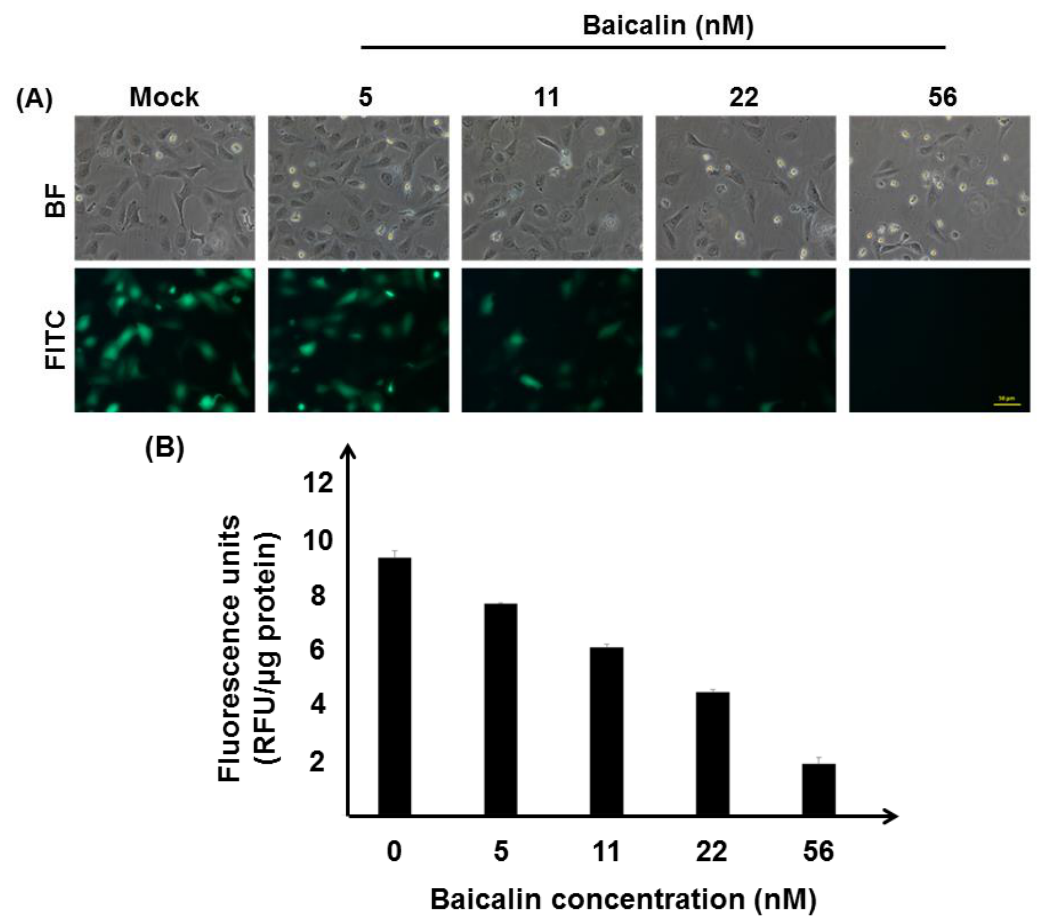
Figure 8. Evaluation of anti-CHIKV ability of baicalin through BacMam virus-based drug screening platform. ( A ) Effects of baicalin on vAc-CMV-CHIKV NS-EGFP BacMam mediated U-2OS cell replication at different concentrations. U-2OS cells were transduced with vAc-CMV-CHIKV NS-EGFP BacMam at a multiplicity of infection (MOI) of 10. After 2 h, the transduced cells were treated with 5, 11, 22 and 56 nM concentrations of baicalin. The replicon activity of CHIKV in mammalian cells using a BacMam system at 1 dpt was examined under a fluorescence microscope with a FITC channel (lower panel) and a bright field (upper panel). The bar represents 50 µm. ( B ) Dose response of baicalin on BacMam-mediated CHIKV replicon activity in U-2OS cells. The graph shows the anti-CHIKV effects of baicalin with respect to the control group (mock). The wavelength of emission and excitation spectra were monitored at 505 nm and 488 nm. All the data were replicated 3 times.